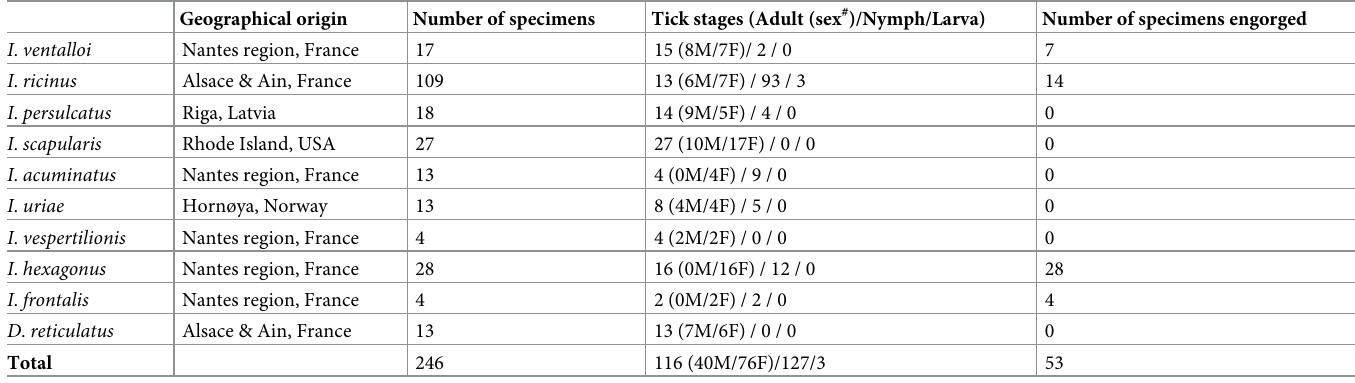
Table 1. Details of tick collection classified by